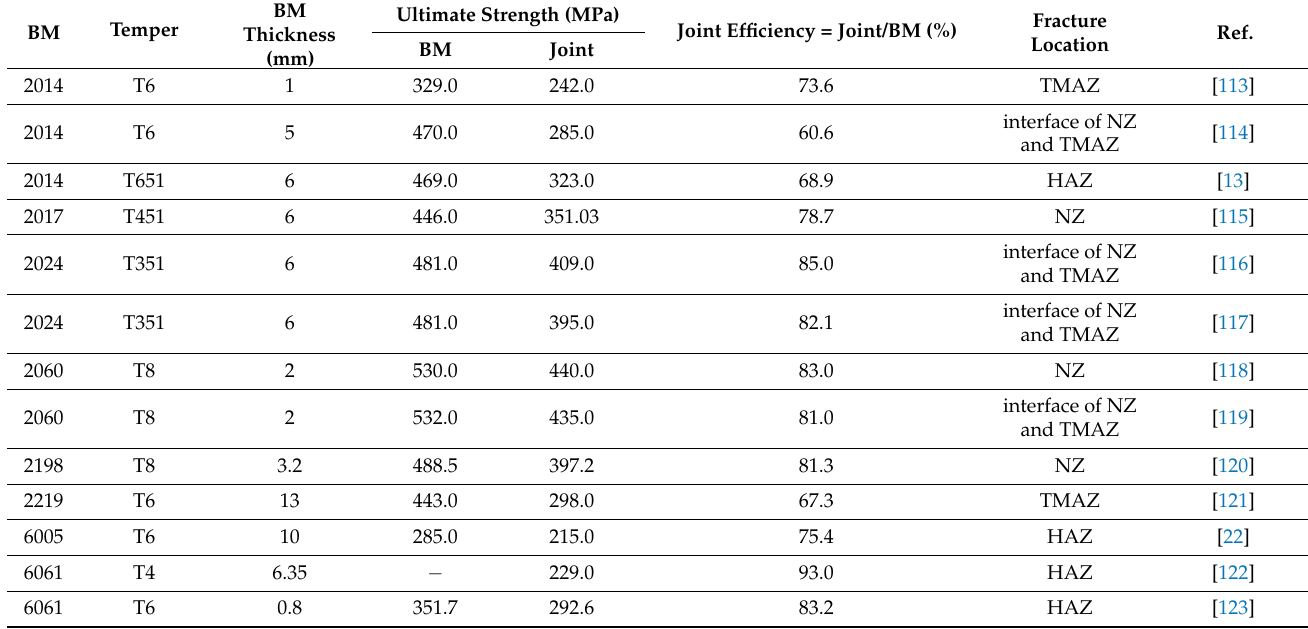
Figure 13. Schematic diagram of friction stir welding [106]. Table 7. Summary of the tensile properties of a conventional FSW age-hardening aluminum alloy butt joint (nugget zone (NZ), thermo-mechanically affected zone